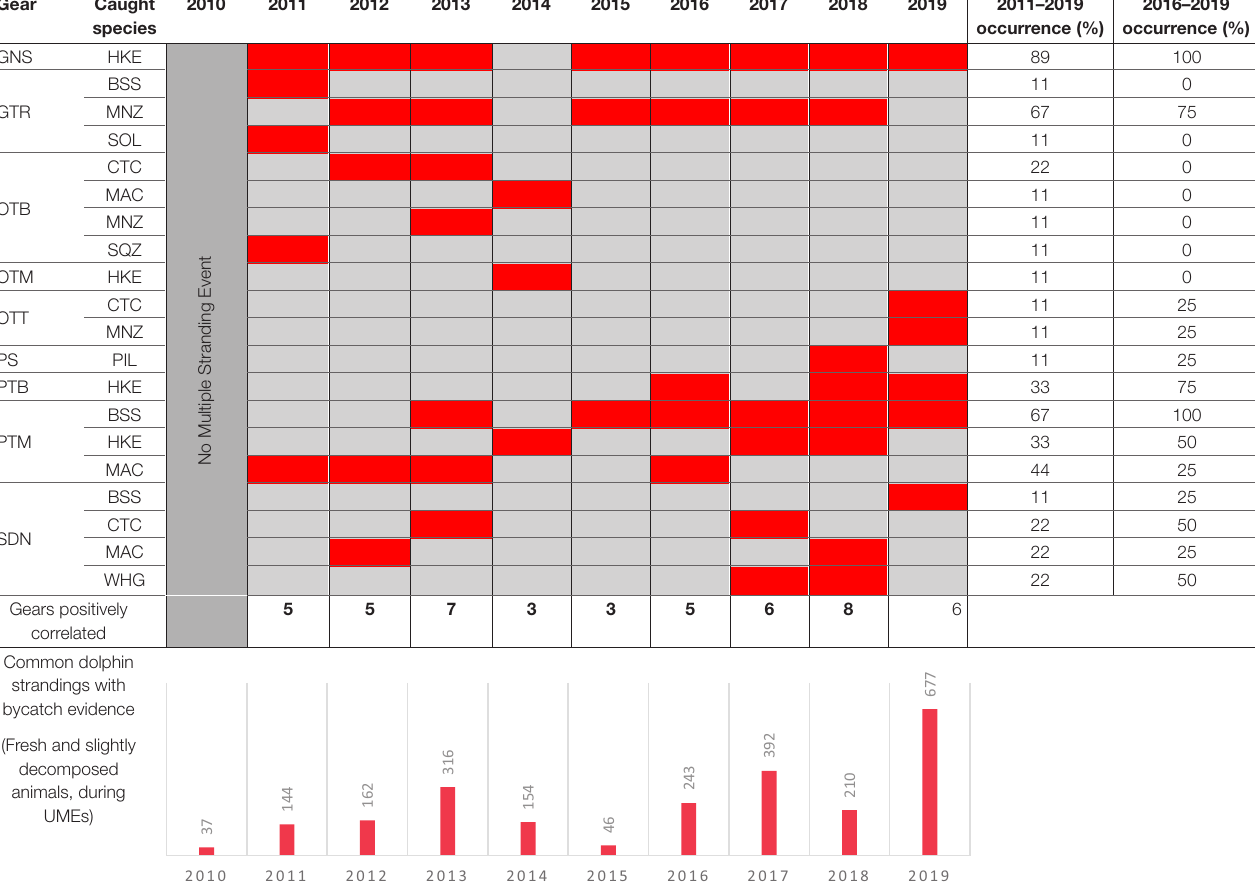
TABLE 6 | Time series of positive correlations (in red) between fishing effort and origin of bycaught common dolphins in ICES subareas 27.8.a and 27.8.b (2010–2019). Gear Caught